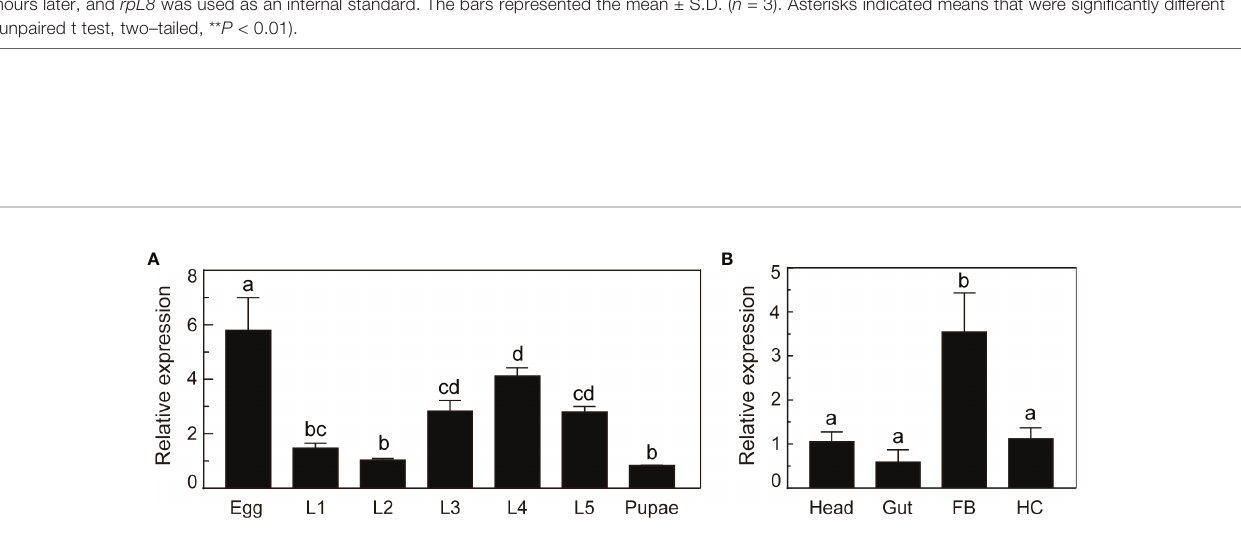
FIGURE 2 | Expression pro fi le analysis of O. furnacalis serpin – 4 . (A) qRT – PCR analysis of O. furnacalis serpin – 4 transcripts at different stages of development. RNA was extracted from eggs, fi rst – instar larvae (L1), second – instar larvae (L2), third – instar larvae (L3), fourth – instar larvae (L4), fi fth – instar larvae (L5) and pupae. (B) qRT – PCR analysis of O. furnacalis serpin – 4 transcripts in different tissues. RNA was extracted from the head, gut, fat body (FB) and hemocytes (HC). The bars represented the mean ± S.D. ( n = 3). The rpL8 gene was used as an internal standard to indicate a consistent total mRNA amount. Bars labeled with different letters were signi fi cantly different (one – way ANOVA, followed by Tukey ’ s multiple comparisons test, P <